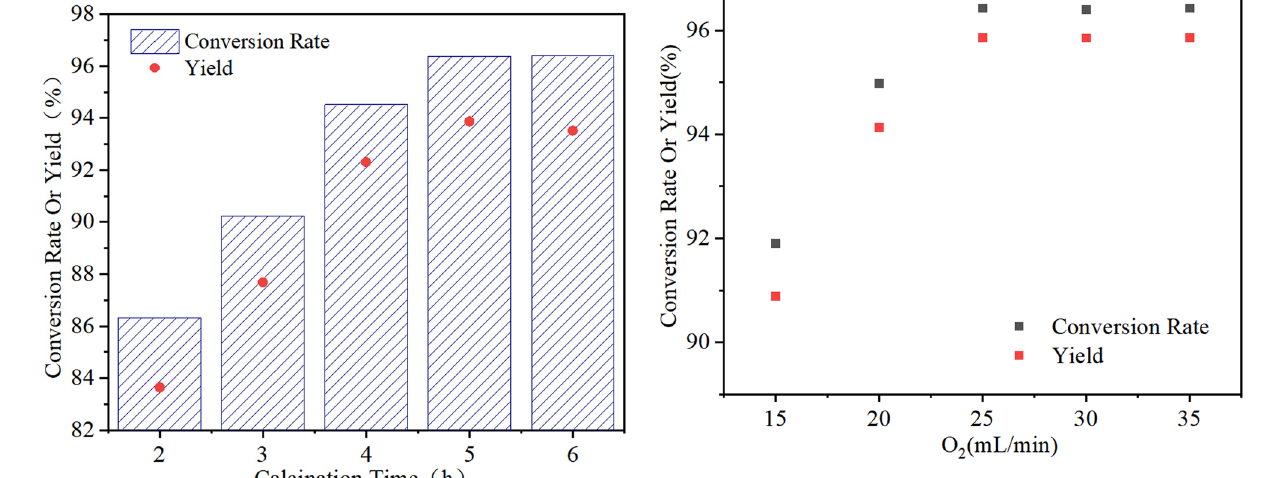
Figure 8: E ff ect of the O 2 amount on the ε - caprolactone yield. Reaction conditions: cyclohexanone ( 0.02 mol ) , benzaldehyde